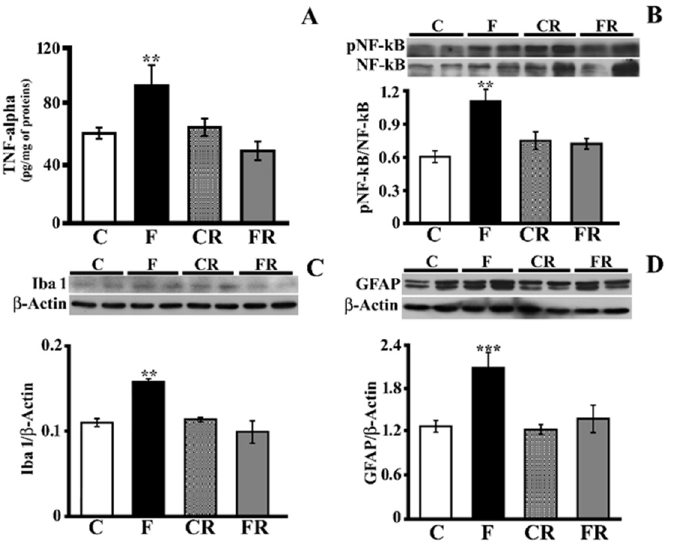
Figure 2. Inflammatory status in the hippocampus ( A )TNF-alpha concentration (titrated by sandwich ELISA), ( B ) activation of NF-kB (expressed as the pNF-kB/NF-kB ratio with representative Western blot), ( C ) Iba1 level (with representative Western blot), ( D ) GFAP level (with representative Western blot) in protein extracts from the hippocampi of control (C), fructose-fed (F), control rescued (CR), and fructose-rescued (FR) rats. Data are the means ± SEM of eight rats/group. ** p < 0.01 versus control rats; *** p < 0.001 versus control rats. Source of variation: one-way ANOVA followed by Tukey’s post-test.